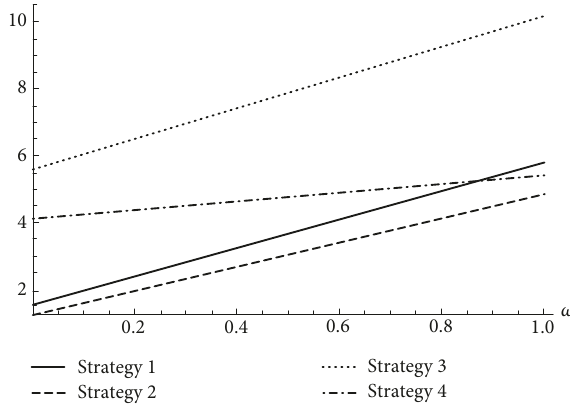
Figure 3: Moviegoers of new theme film under different star selection